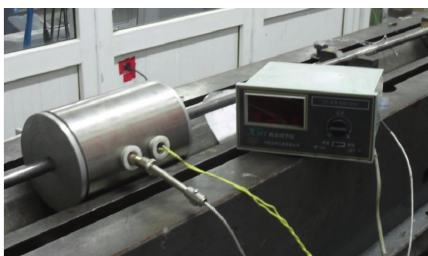
Figure 3: A heating device for the specimen in Hopkinson